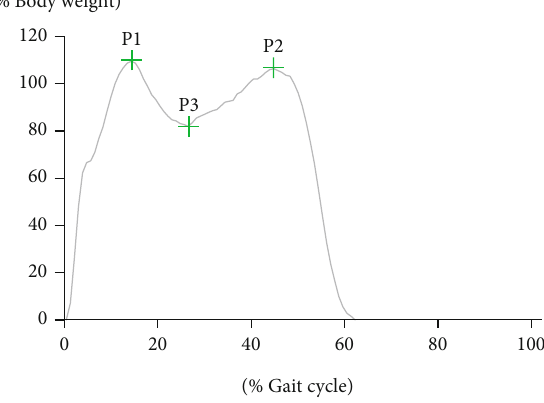
Figure 3: Peak values of vertical ground reaction force. P1: fi rst maximal peak; P2: second maximal peak; P3: minimal